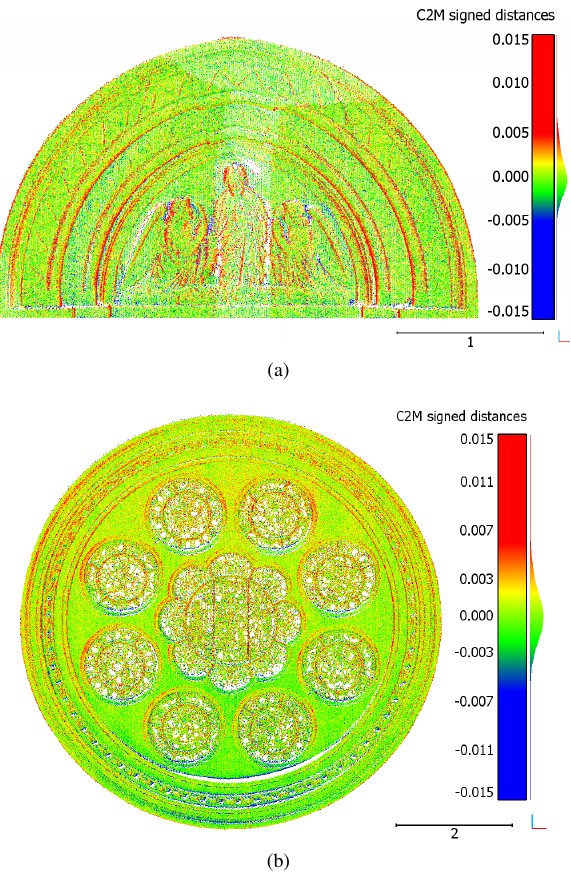
Figure 7. Cloud-to-mesh deviations (in m) observed on detailed parts and projected on Trimble SX10 point cloud: (a) central tym- panum and (b) rose